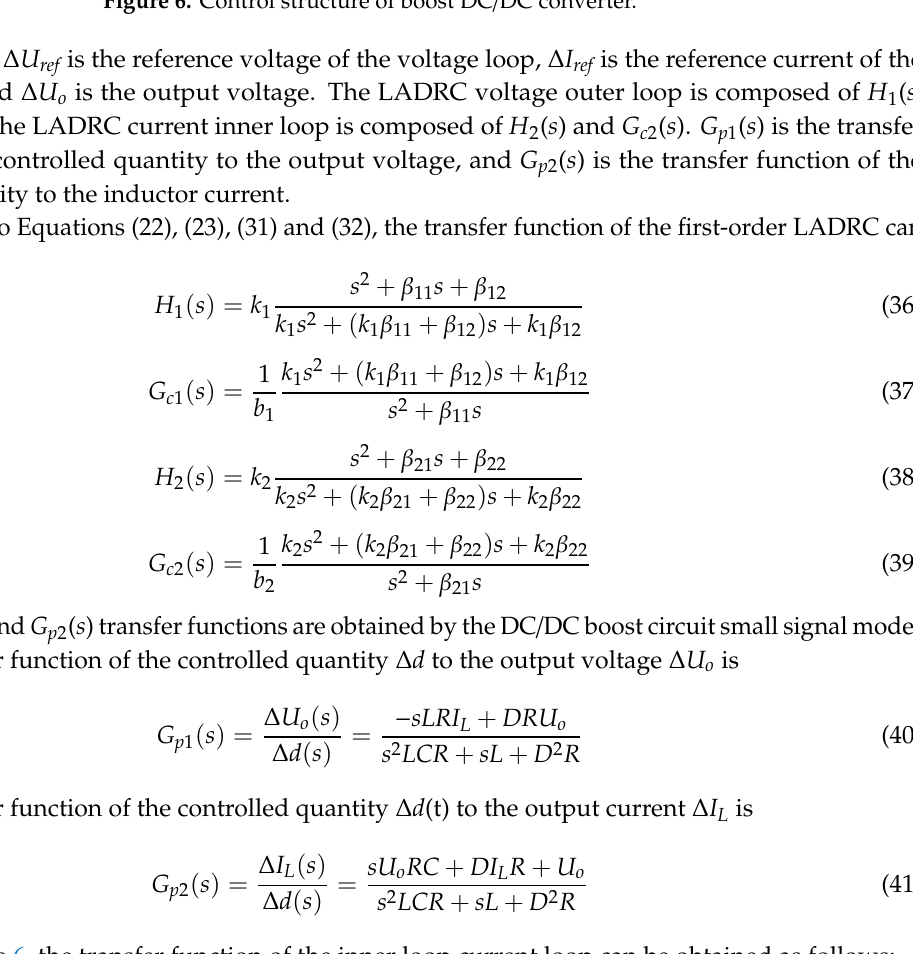
Figure 4. The structure of proposed controller. 4.3. System Stability Analysis The transfer function of the DC/DC boost converter can be obtained from Equation (4) 2